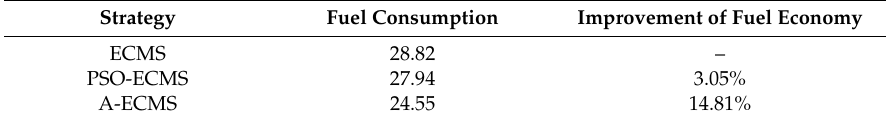
Table 7. Fuel consumption of hybrid heavy-duty vehicle under ECMS, PSO-ECMS and A-ECMS.